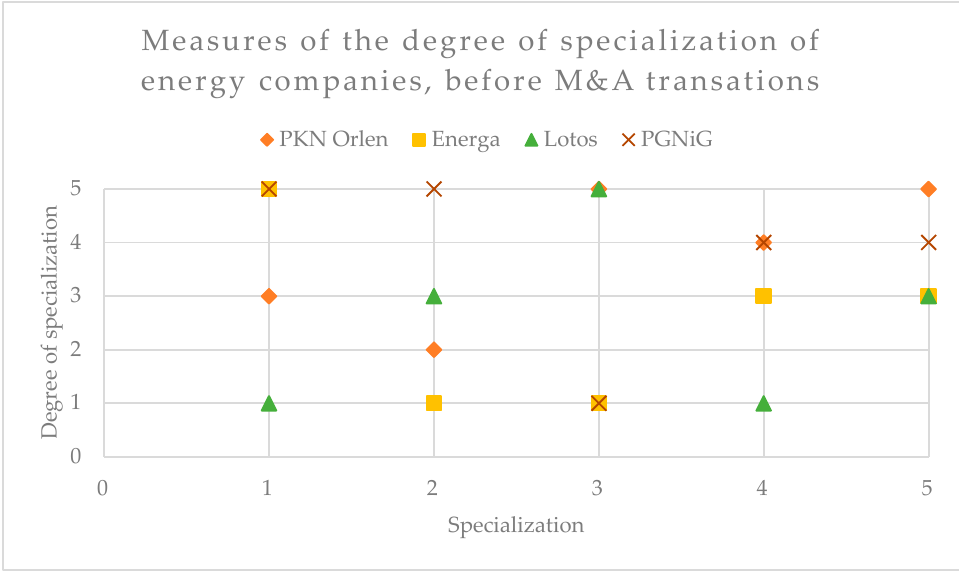
Figure 6. Distribution of the diversification and integration degree of a multi-energy concern before M&A transactions. Explanations for Figure 6: The values in the columns represent the individual specializations of energy companies (before M&A transactions), in accordance with Table 8. The values in the rows represent the degree of these specializations, according to the adopted scale. Source: authors’ own studies.